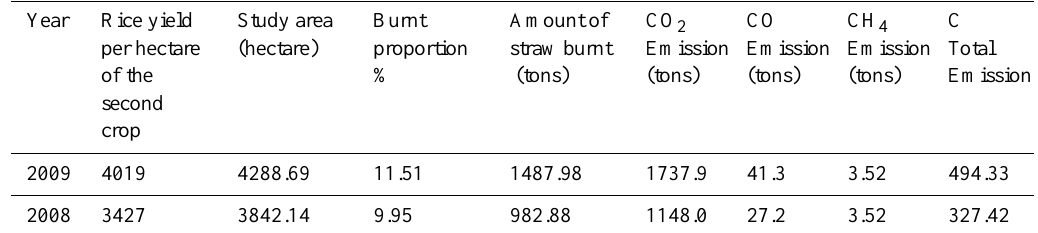
Table 4. Estimation of carbon emissions from open rice straw burning within the study area (Xikou Township) during